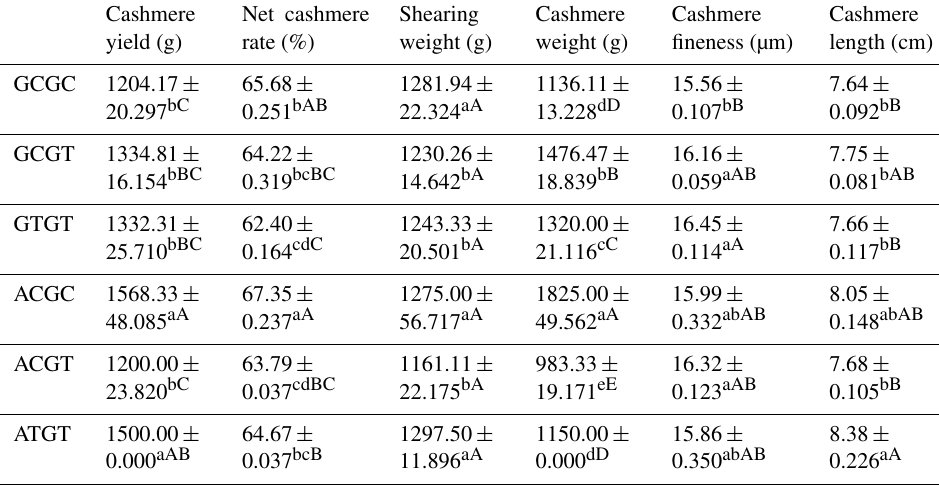
Table A10. Association analysis of haplotype body cashmere performance.